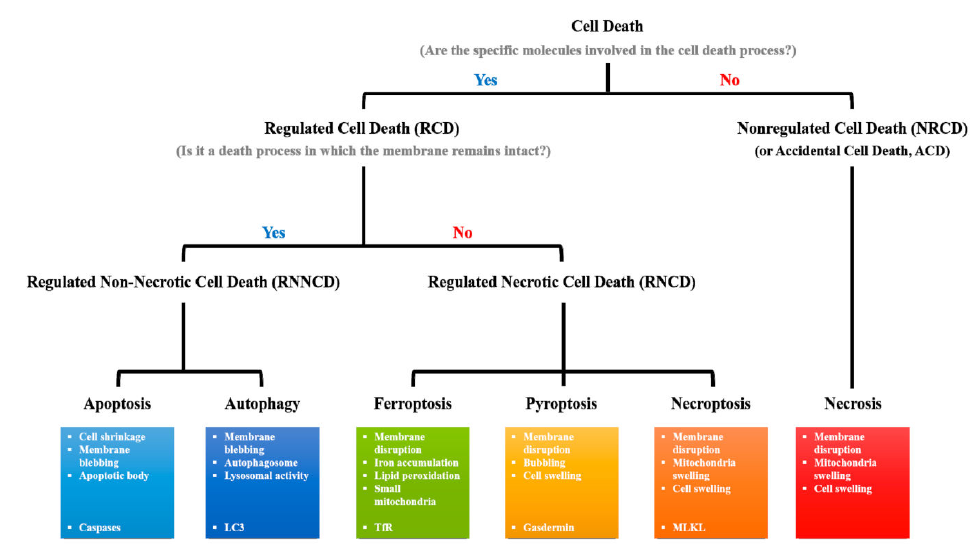
Figure 1. Classification of cell death types. Cell death types can be classified according to whether they are regulated by a specific signal pathway. Except for necrosis, most types of cell death are included in the RCD category. The type of RCD can also be classified according to membrane disruption. Apoptotic- and autophagic-cell death does not induce additional inflammatory responses, because their cellular components are sequestered within the membrane structures, such as apoptotic bodies and autophagosomes, respectively, during cell death processes. However, since RNCDs, including ferroptosis, pyroptosis, and necroptosis, are death types accompanied by membrane disruption, RNCDs can induce inflammatory responses in the